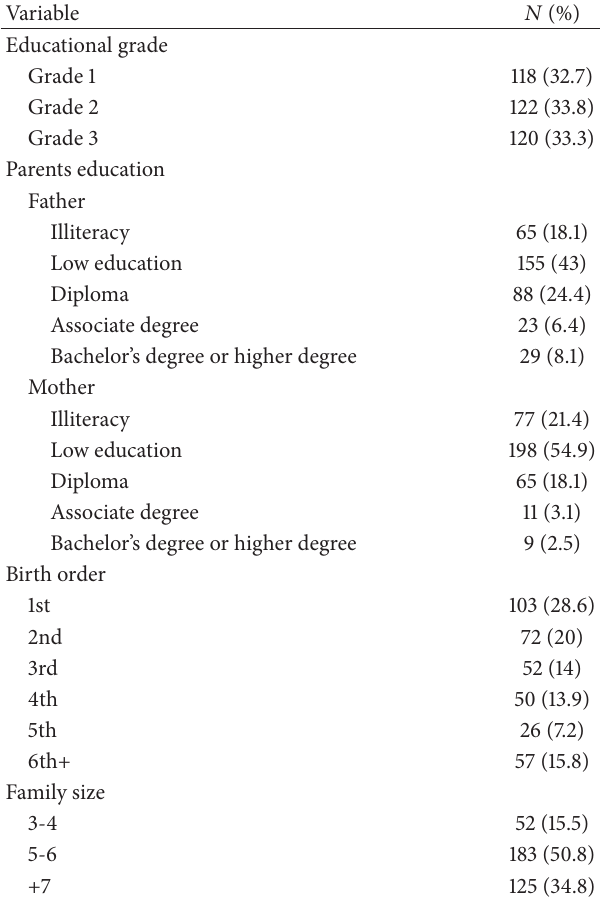
Table 1: Demographic characteristics of